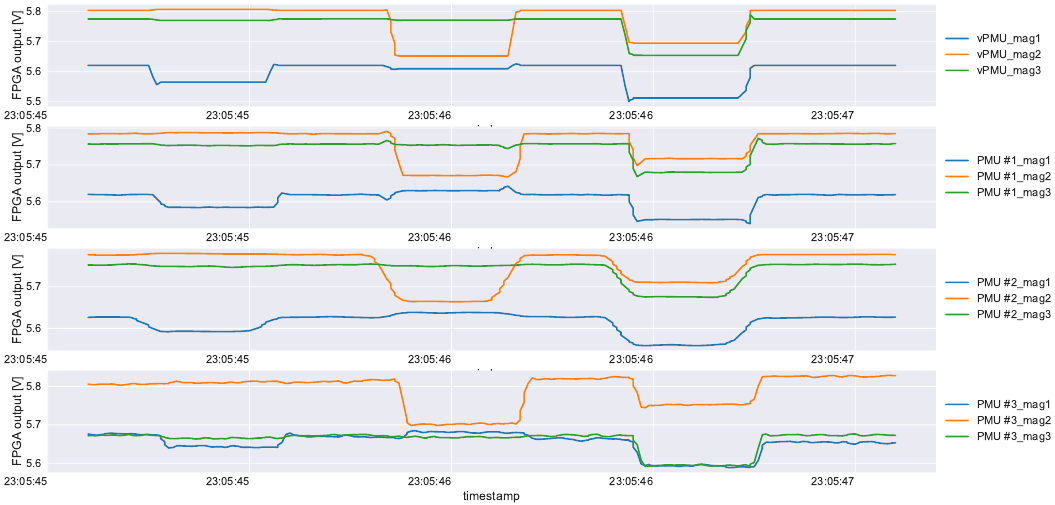
Figure 10. Fault scenario sequence: vPMU measurements; PMU #1 measurements; PMU #2 measurements; PMU #3